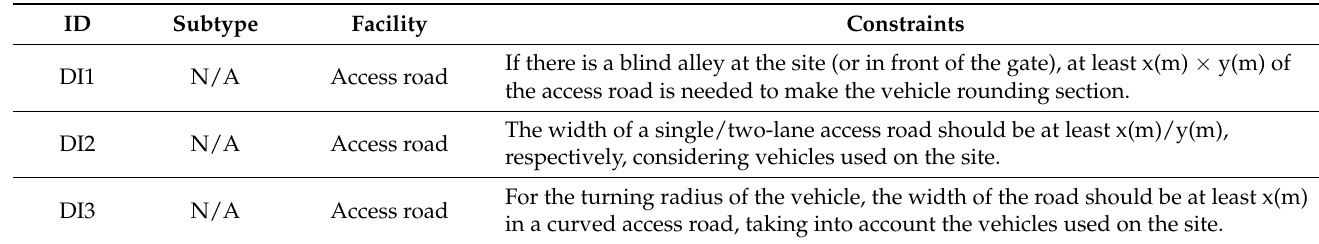
Table 3. Dimensional type constraints identified in this